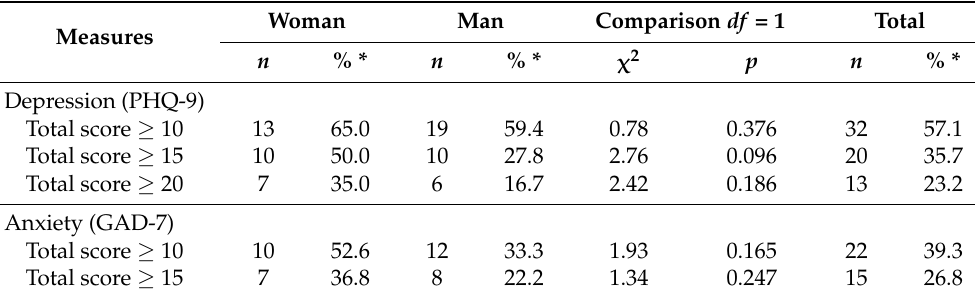
Table 3. Prevalence of depressive symptoms and